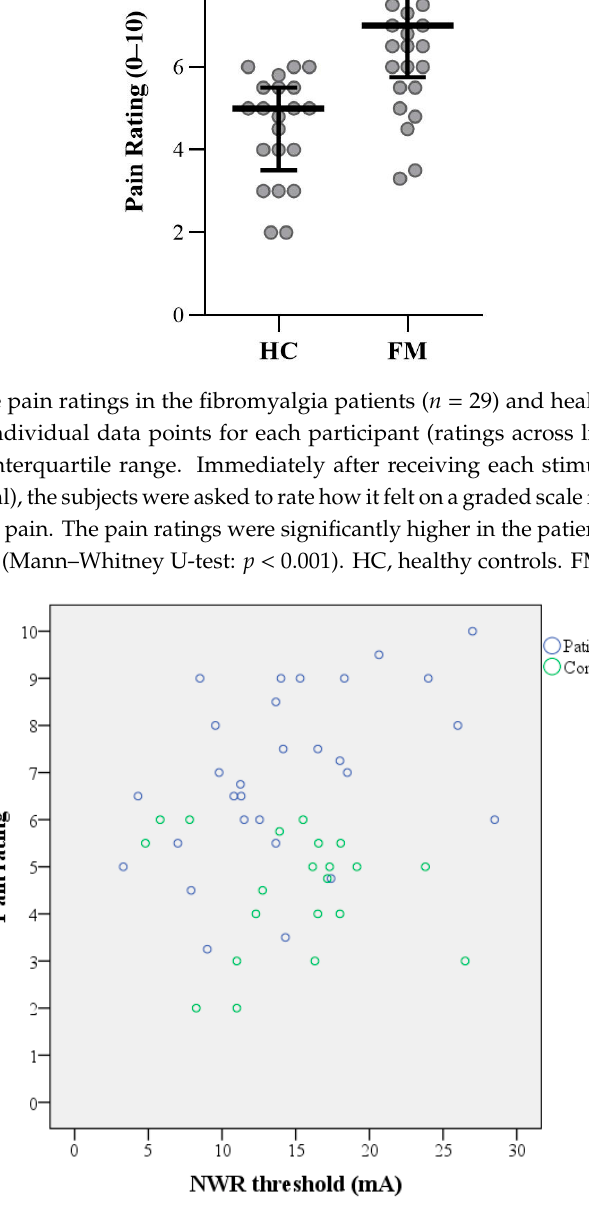
Figure 2. Subjective pain ratings plotted against the NWR thresholds in the fibromyalgia patients ( n = 29) and healthy controls ( n = 21). In subjects where NWR thresholds were obtained from both limbs, these and the corresponding pain ratings were averaged. A positive linear correlation was seen in the patient group (Spearman’s Rho = 0.460; p = 0.012).